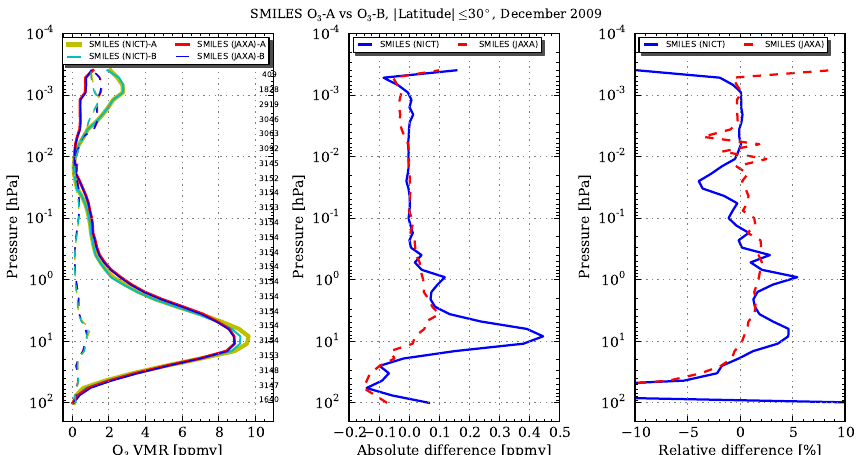
Fig. 6. Comparison of O 3 profiles retrieved from Band-A and Band-B when these frequency bands were operated simultaneously (December 2009). Left panel shows the mean VMR profiles (solid) for O 3 from Band-A and B processed by the SMILES(NICT) and SMILES(JAXA) L2 chains. Dashed profiles represent the standard deviation of each dataset. Small numbers on the right of the panel are the numbers of data points used in the averaging. Center and right panels are the absolute and relative differences of O 3 retrieved from Band-A and Band-B for SMILES(NICT) and SMILES(JAXA) products respectively.